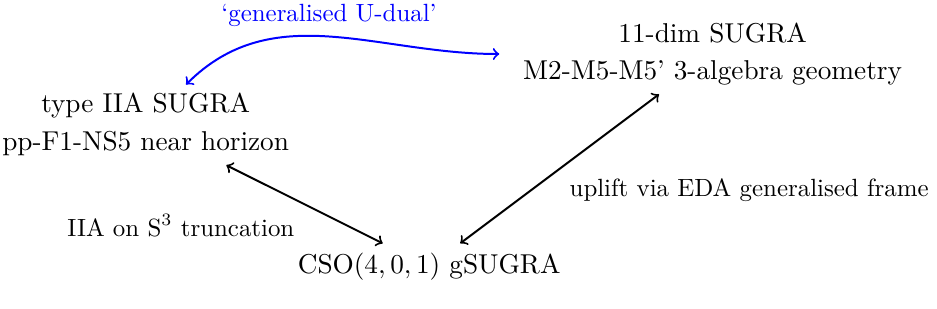
Figure 1 . The relationship between our